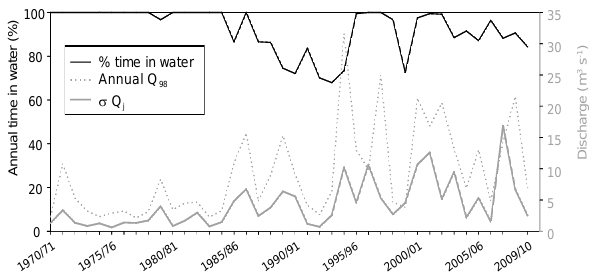
Figure 8. Variation of hydrological regime with annual percentage of time of flowing water, Q 98 (amongst daily discharges, per year) and annual standard deviation of daily river